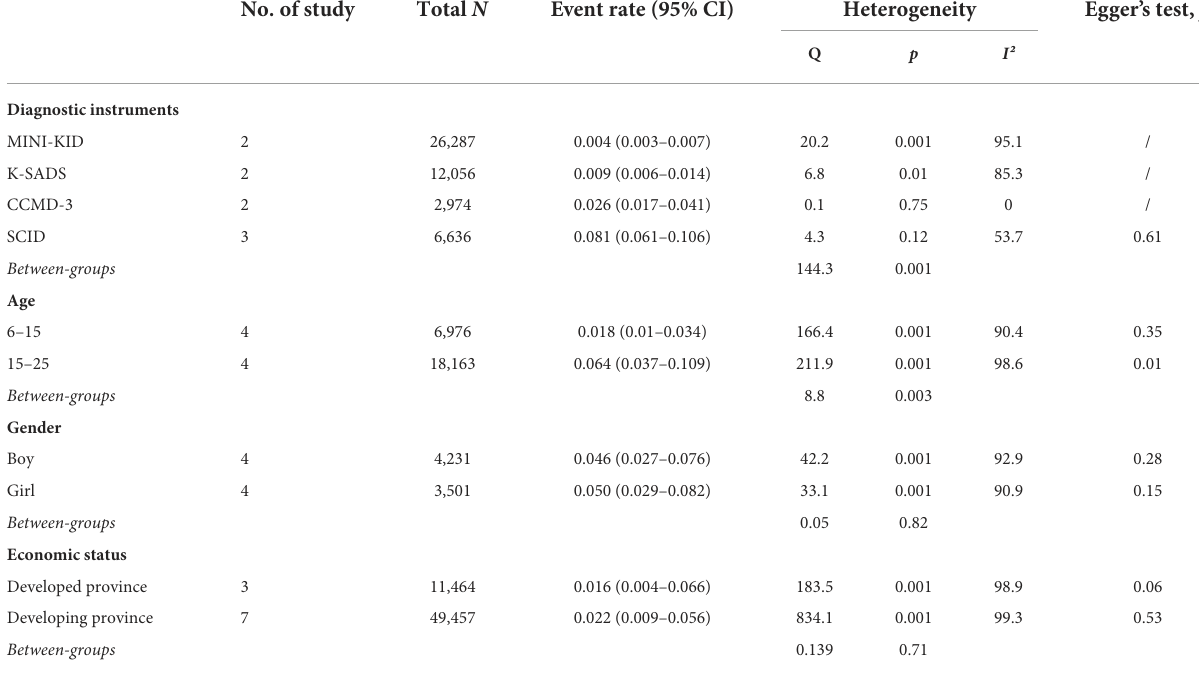
TABLE 3 Pooled event rates of social anxiety disorder grouped by